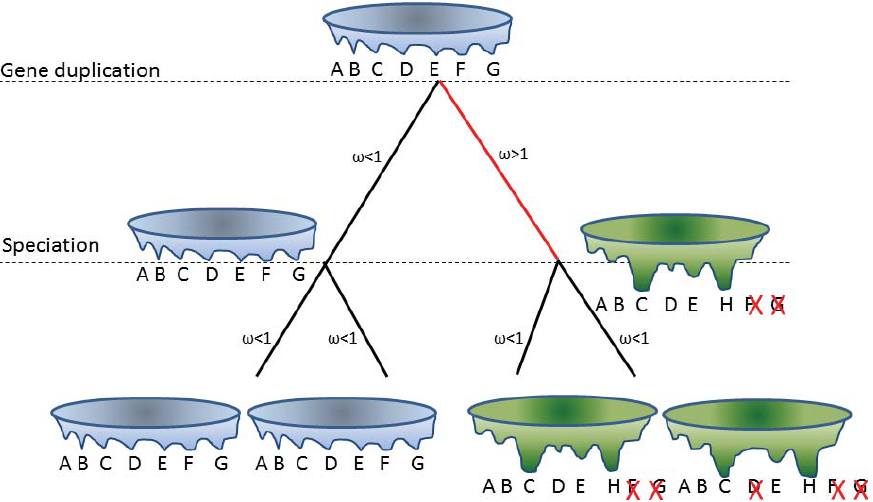
Figure 2. Evolution of an energy landscape and its conformational ensemble after gene duplication. At the root, the gene giving rise to the protein with the blue energy landscape resulting in conformations A to G is duplicated. At the next speciation event we can see that the two different gene copies have evolved along different trajectories. The blue copy at the speciation node has evolved under negative selection and resembles the ancient blue. The green copy at the speciation node has evolved under positive selection and of the original conformational ensemble, conformations F and G are no longer forming, but a new conformation, H, is forming. In addition, the equilibrium of the conformations is different in the blue vs. green energy landscapes. From the speciation node down to the extant sequences, blue is much conserved, while green although under negative selection, will lose conformation D, in one lineage. Analysis of the extant sequences would show that blue and green are structurally disordered homologs. However, although all these proteins are structurally disordered, the conformational ensembles differ between blue and green (while being the same within the blue copies, and very similar within the green